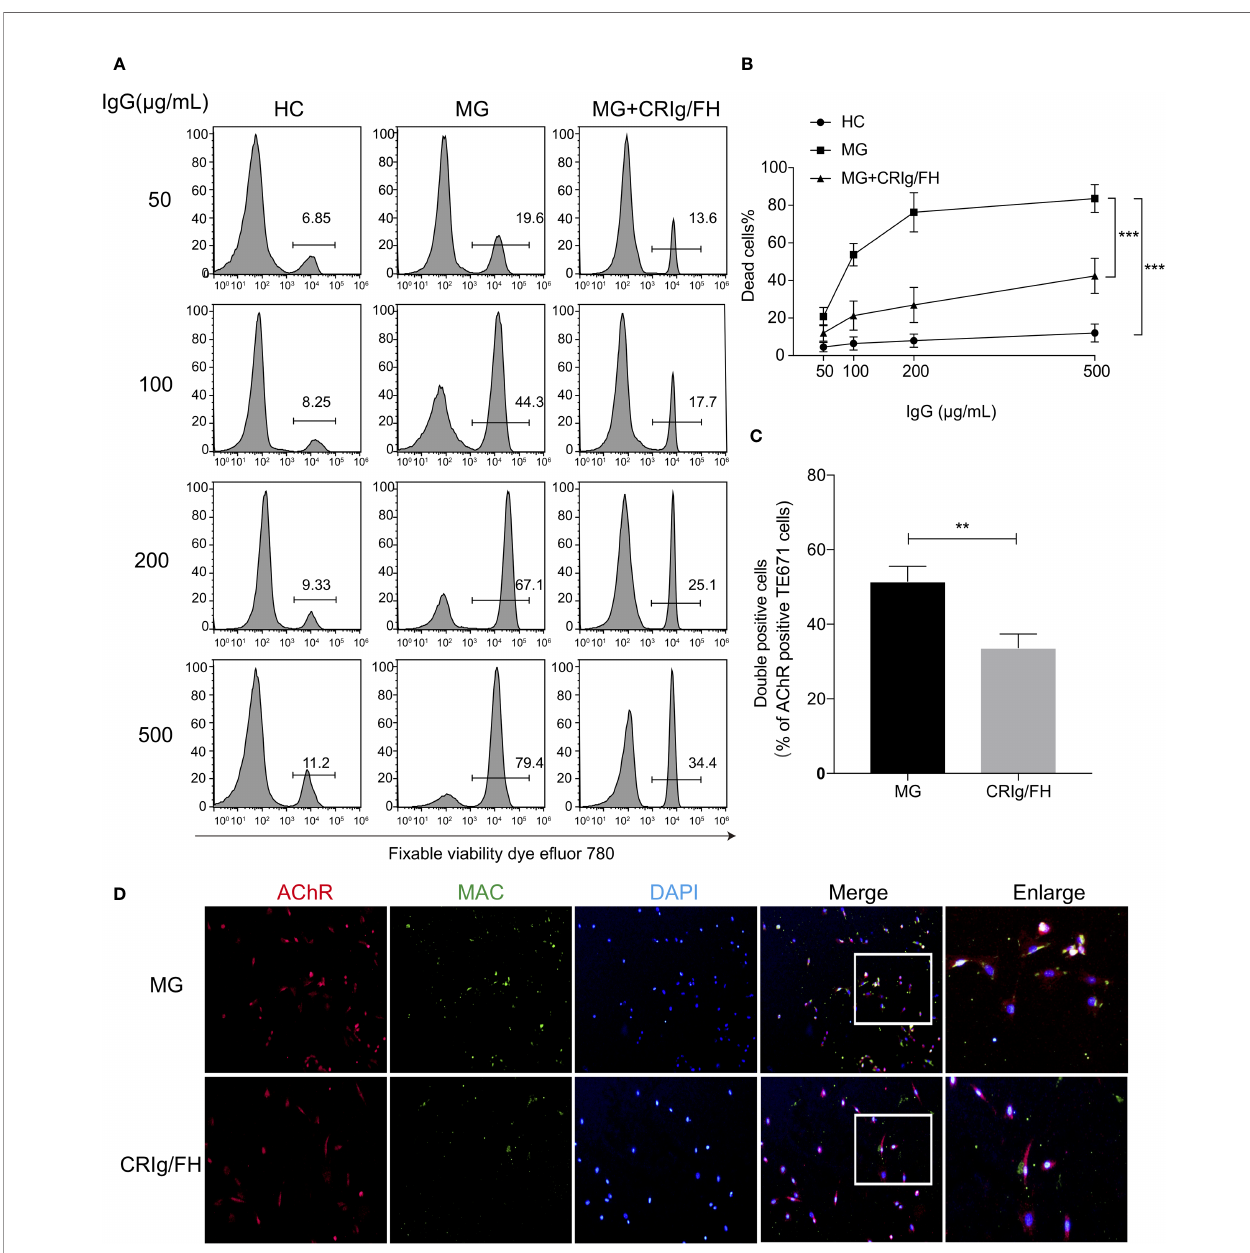
FIGURE 1 | CRIg/FH inhibits MG IgG-mediated CDC and complement deposition on TE671 cells. (A, B) CRIg/FH protects TE671 cells from MG IgG-mediated CDC. TE671 cells were treated with various concentrations of MG-IgG in the presence or absence of CRIg/FH (60 m g/ml). Pooled normal human complement serum (10%) was used as a source of complement. The dead cells were stained by fi xable viability dye eFluor 780 and detected by fl ow cytometry. The representative images in (A) , and the quantitative data as mean ± SD in (B) ; n = 10/group, *** p < 0.0001; two-way ANOVA with Tukey ’ s multiple comparison test. (C, D) CRIg/FH prevents MAC deposition on TE671 cells. TE671 cells were incubated with MG patients derived IgG (200 m g/ml), normal human serum (10%) and CRIg/FH (60 m g/ ml), and stained for MAC (anti-C5b-9n; green), AChR (identi fi ed by a -Bungarotoxin; red), and 4 ′ ,6-diamidino-2-phenylindole (DAPI; blue). Quanti fi cation of immuno fl uorescence images is shown in (C) . The percentage of double-stained cells (MAC and AChR) was quanti fi ed and plotted. Data are expressed as mean ± SEM; two-tailed t -test (** p < 0.01). Representative images are shown in (D)